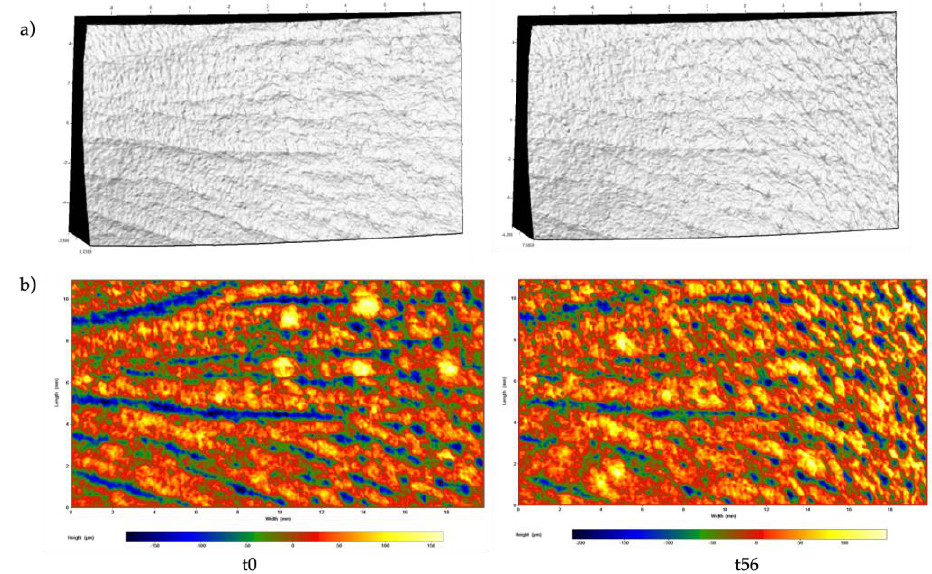
Figure 2. Shown is a 3D picture of wrinkles in the eye contour obtained with Primos Premium equip- ment from one of the volunteers before (t0) and after 56 (t56) consecutive days of application of the placebo formulation, twice daily. ( a ) Photography; ( b ) Representation of the relief in a colored image, where the blue color represents the deepest areas, and depth decreases moving from green to red, orange, and yellow (the highest areas).